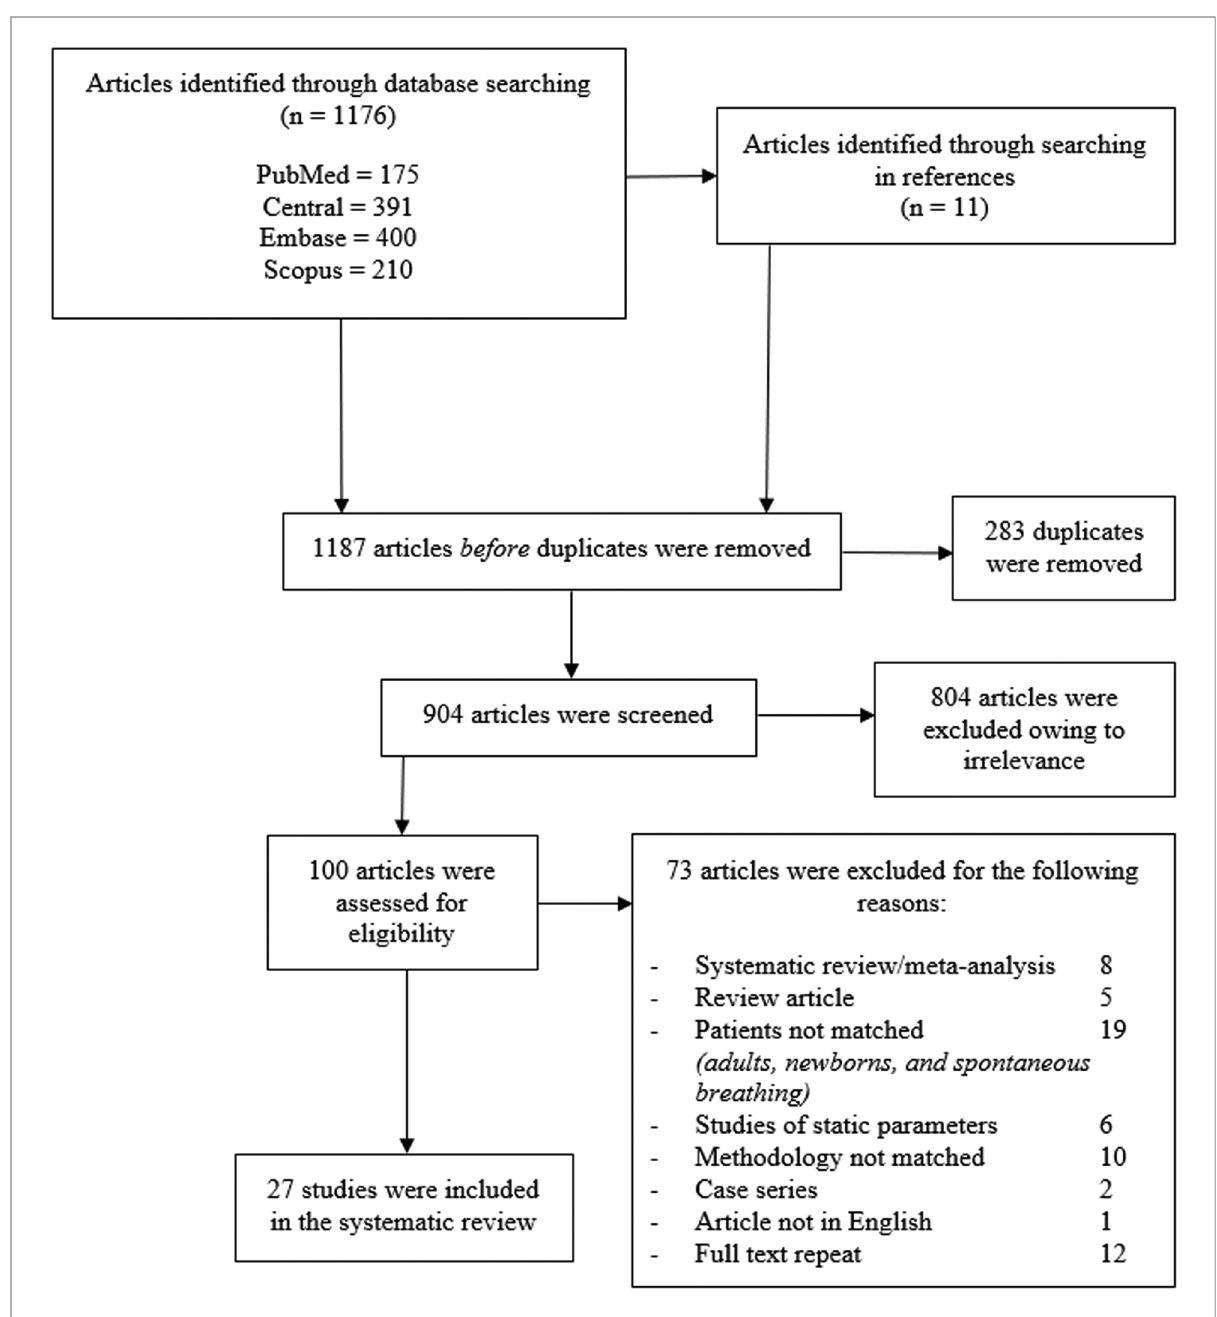
FIGURE 1 Flowchart of a literature search and study